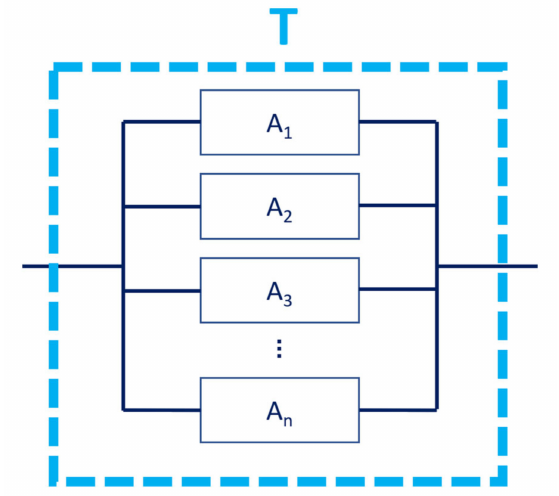
Figure 23. Reliability diagram for task T with respect to agents in the MAS.